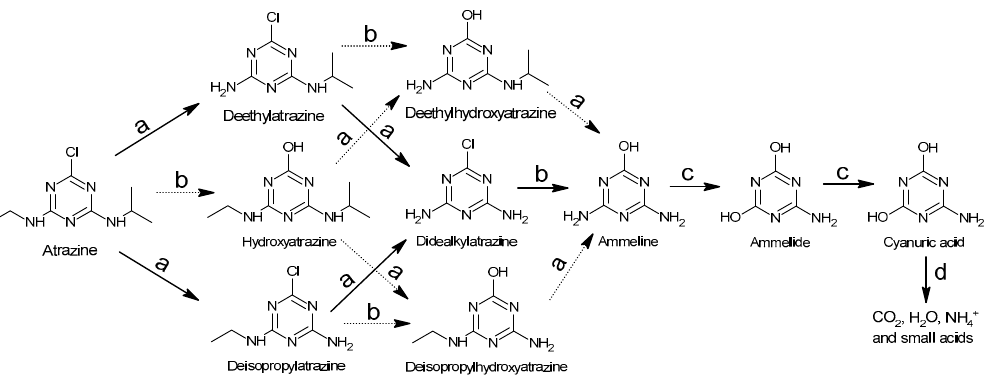
Figure 4. General involved degradation mechanisms of atrazine: ( a ) dealkylation of the amino groups; ( b ) dechlorination and hydroxylation of the s-triazine ring; ( c ) oxidation of the amino groups and deamination; ( d ) the opening of the s-triazine ring.